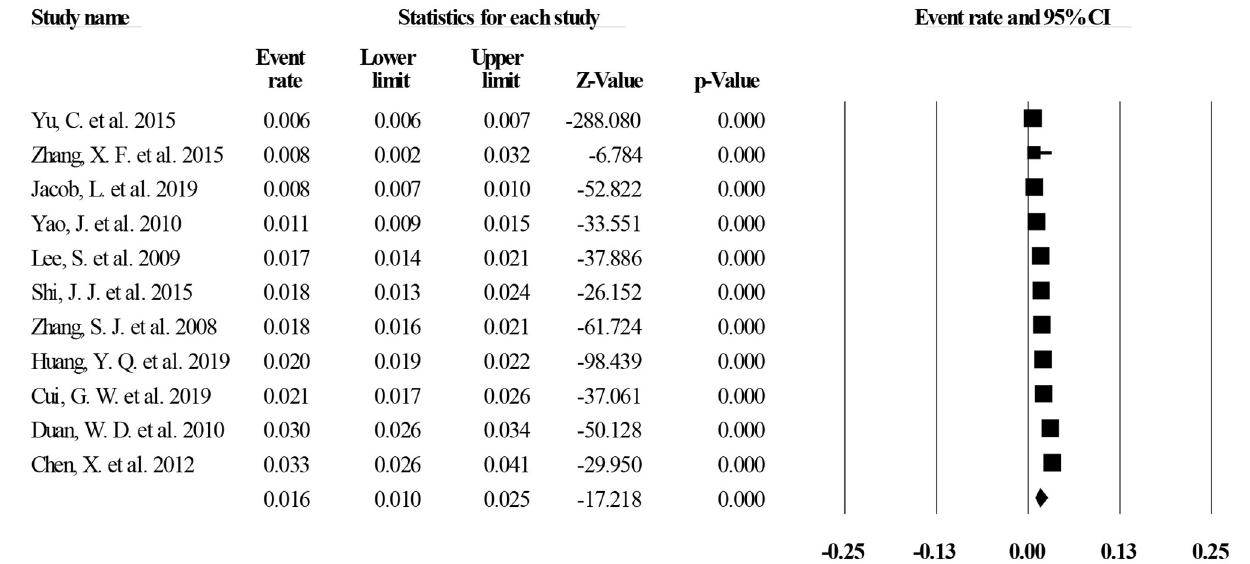
FIGURE 3 | Twelve-month prevalence of MDD in